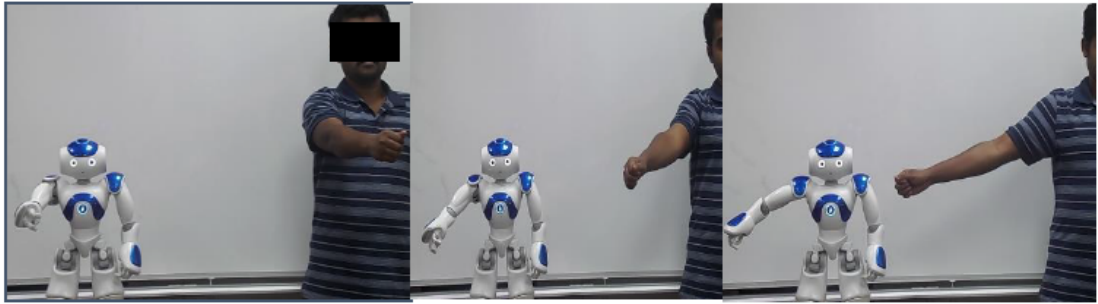
Figure 15: Arm position of human operator and NAO robot during Shoulder joint horizontal flexion/extension motion during teleoperation